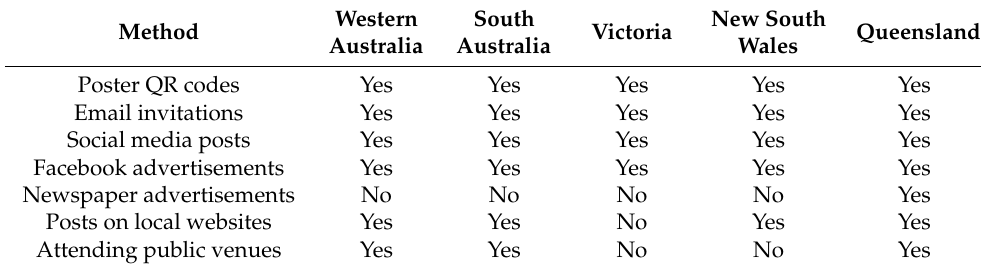
Table 1. Summary of recruitment methods in each participating Australian